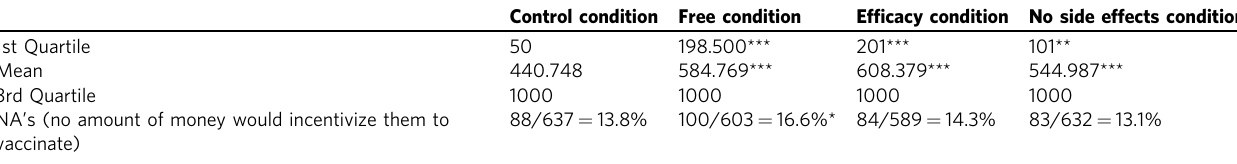
Table 4 WTA and NA ’ s in each condition for hesitants.